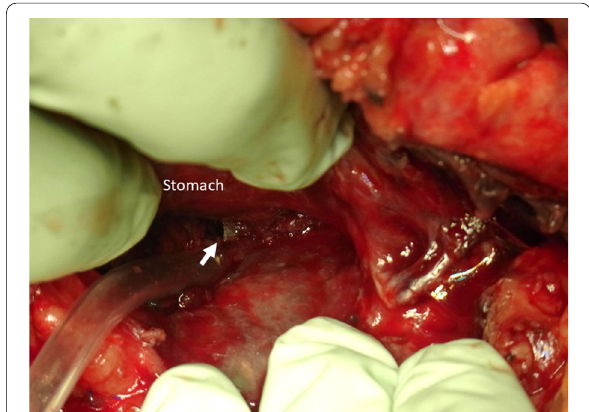
Fig. 5 Intraoperative findings during the second operation. The Arterial wall of the common hepatic artery disappeared, and the stent graft (arrow) was